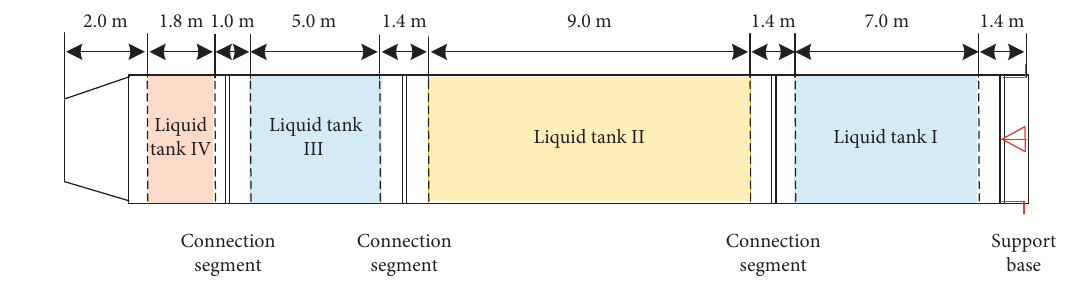
Figure 2: Structure of the four-stage series liquid storage tank. Table 1: Structural dimensions and material properties of the liquid storage tank.